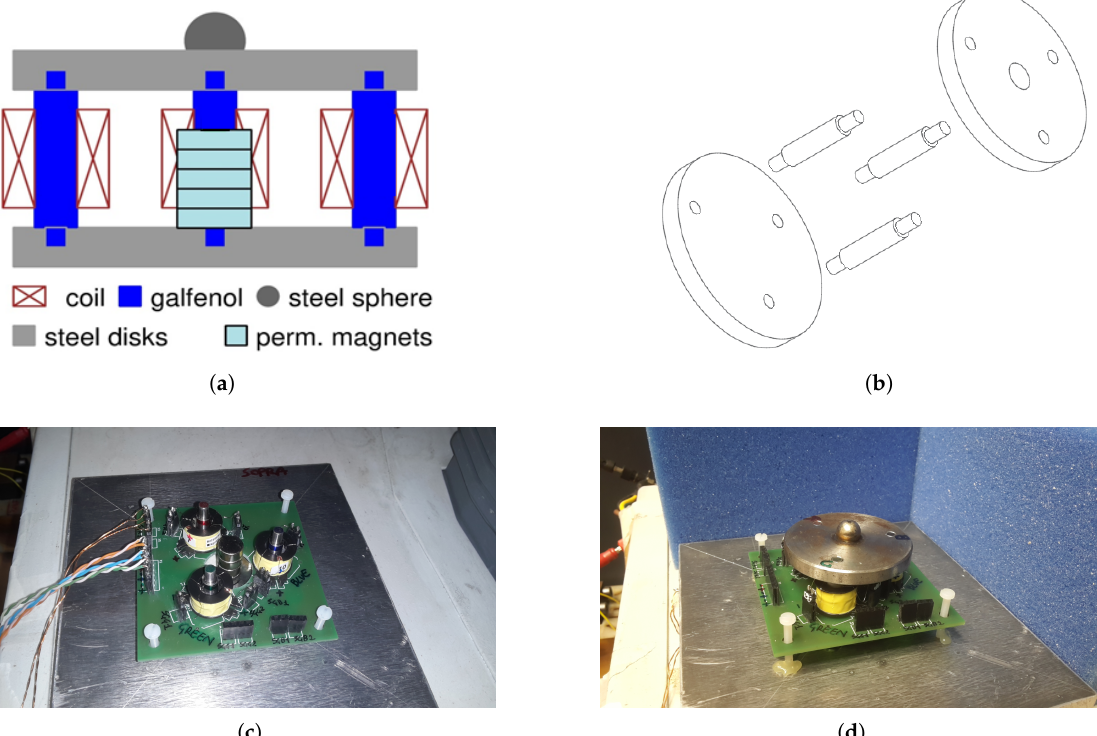
Figure 7. KEH device based on three Galfenol rods. PMs are inserted to provide the magnetic bias. ( a ) 2-D sketch. ( b ) 3-D sketch. ( c ) Photo of the PCB, PMs and Galfenol rods during installation. ( d ) Photo of the whole 3-rod kinetic energy harvesting